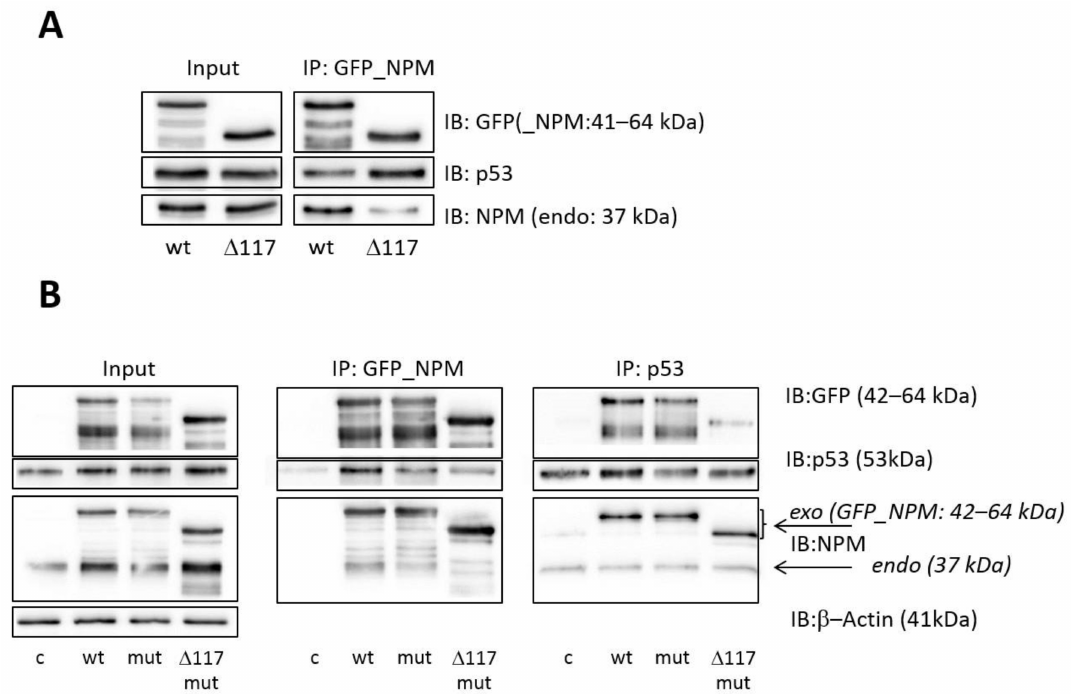
Figure 4. Interaction of p53 with ∆ 117 variants of NPM in lysates of HEK-293T cells. ( A ) Interaction of p53 with ∆ 117wt. Cells were transfected with G_ ∆ 117wt or G_NPMwt for control. Levels of co-precipitated endogenous NPM and p53 differ between the samples; ( B ) interaction of p53 with ∆ 117mut. Cells were transfected with G_NPMmut, G_ ∆ 117mut or G_NPMwt for comparison. Untransfected cells (c) served as a precipitation control. Levels of co-precipitated proteins were investigated by immunoblotting. β -Actin expression served as a loading control. Abbreviations can be found in Table